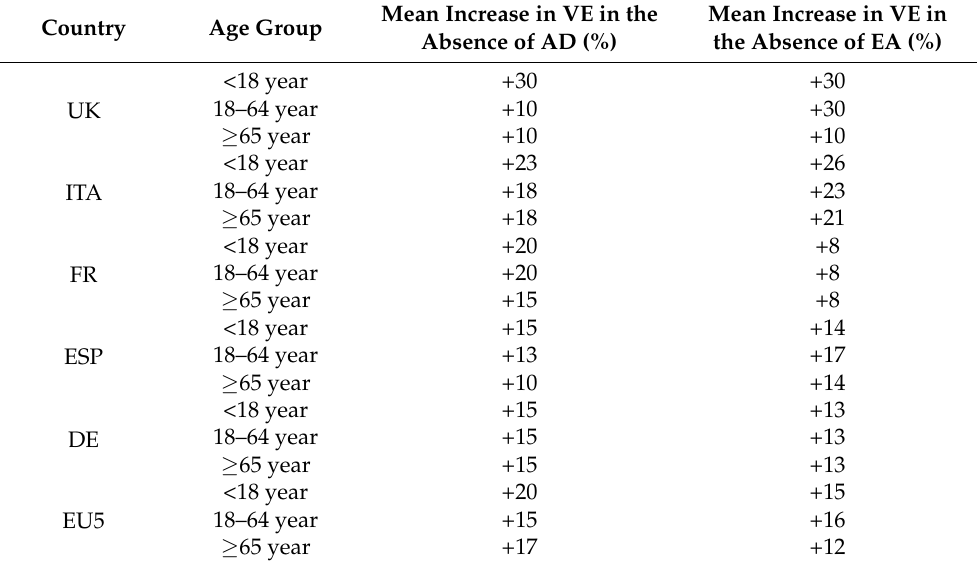
Table 4. Experts’ mean estimates of the absolute increase in A(H3N2) vaccine effectiveness in the absence of antigenic drift or egg adaptation changes for each country between 2014 and 2019.